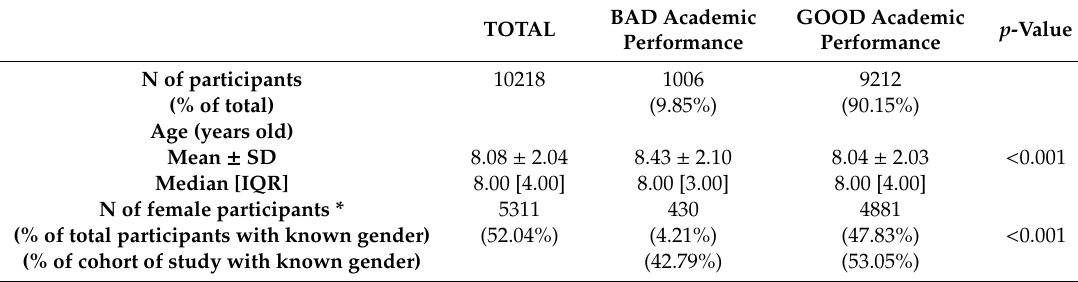
Table 1. Demographic analysis of the study population.